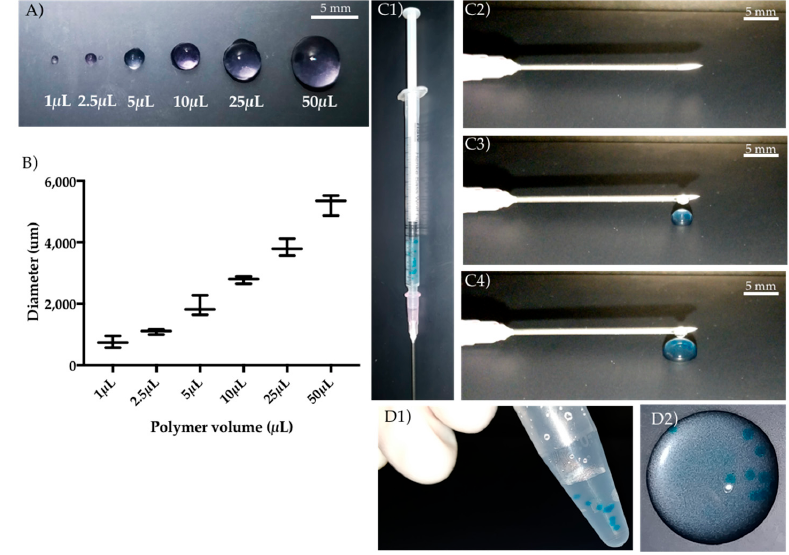
Figure 1. Production and injectability of gellan gum (GG) hydrogel particles. ( A , B ) Spherical particles with different sizes ranging from 700 to 5000 µ m of diameter, approximately are obtained by dispensing different volumes of polymer solution (from 1 to 50 µ L). ( C ) The obtained particles (previously stained with methylene blue) are loaded in a GG solution ( C1 ) that acts as vehicle to confirm its injectability through a needle of 27G ( C2 – C4 ). ( D ) The integrity of the particles before ( D1 ) is maintained after injection ( D2